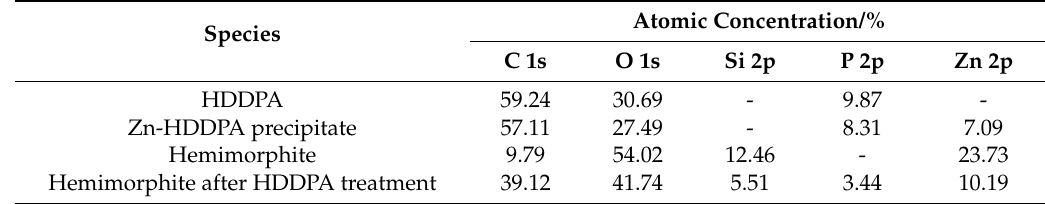
Table 2. Atomic concentration of elements as determined by X-ray photoelectron spectroscopy (XPS).